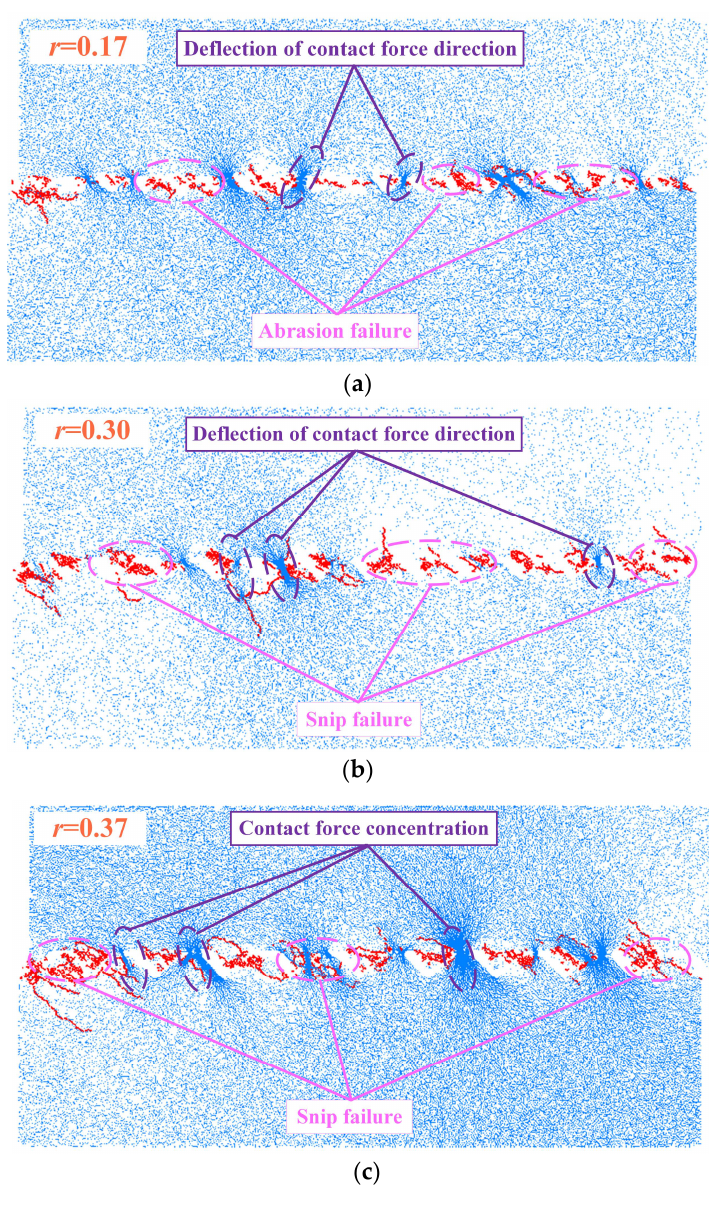
Figure 13. Contact force distribution of samples with different roughness at end of the tests: ( a ) roughness r = 0.17; ( b ) roughness r = 0.30; ( c ) roughness r = 0.37.